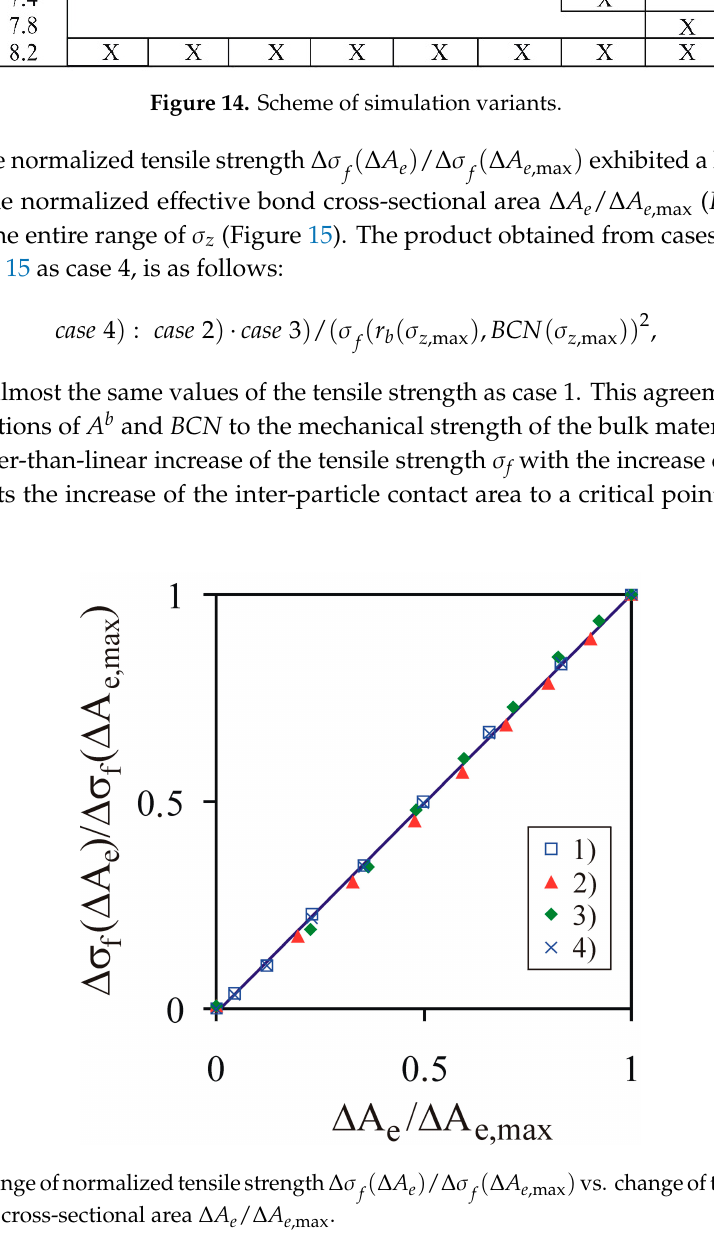
Figure15. Changeofnormalizedtensilestrength ∆ σ Figure 15. Change of normalized tensile strength )(/)( e ff ective bond cross-sectional area ∆ A e / ∆ A e ,max normalized effective bond cross-sectional area